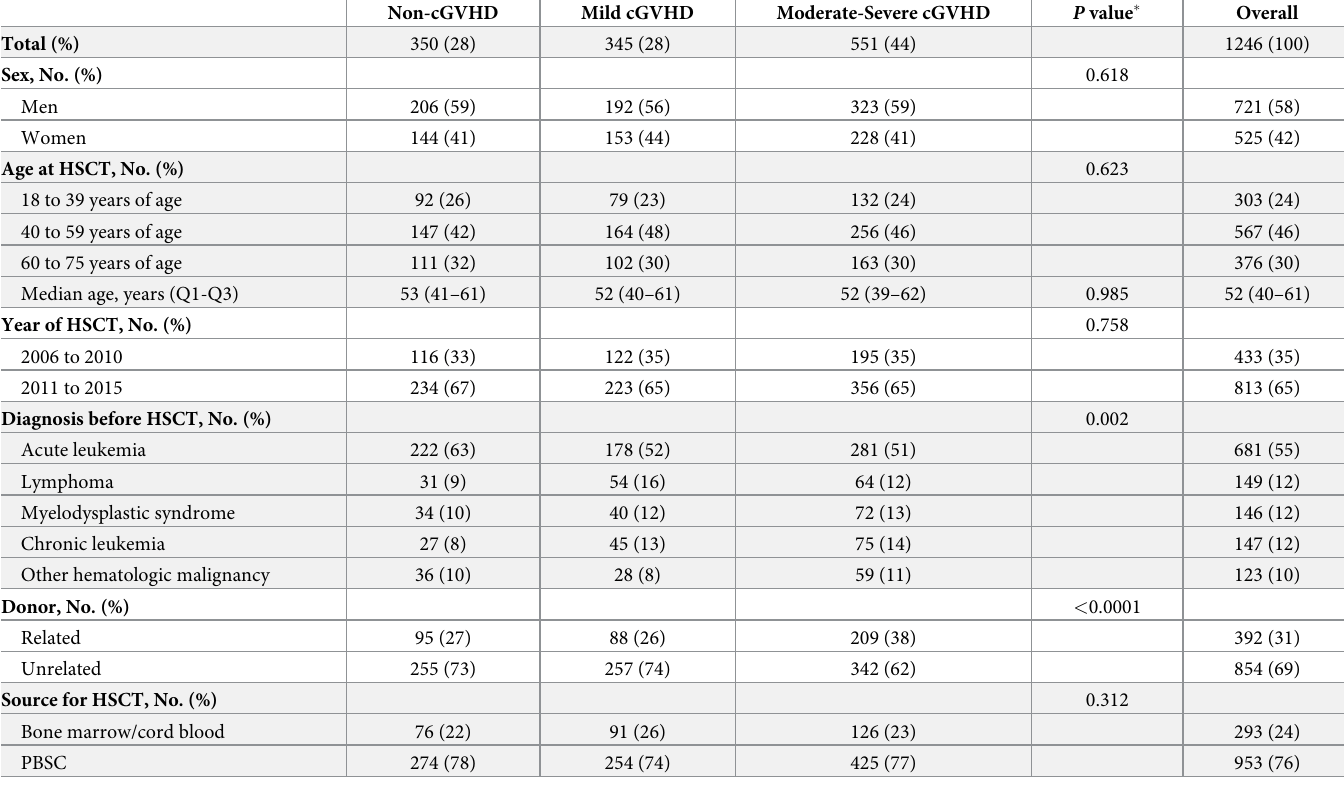
Table 1. Characteristics of Swedish patients who underwent HSCT between 2006 and 2015 and survived � 6 months post-HSCT by cGVHD